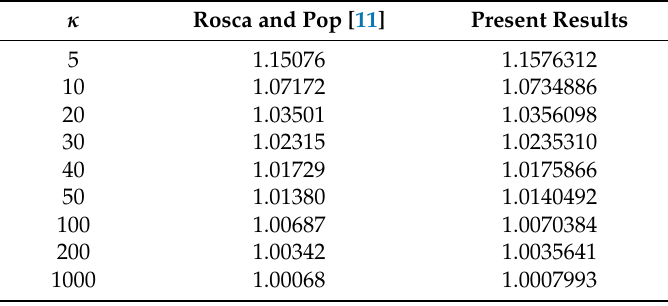
Table 5. Comparison of our numerical values for − Re 0.5 s Cf s with existing results for different values of κ , when φ = ε = Ec = M =